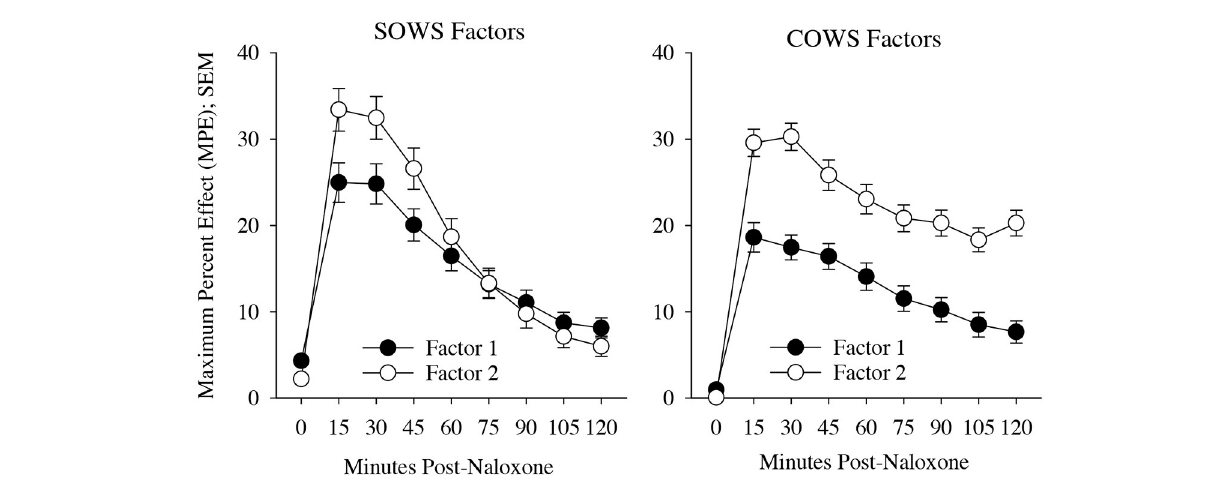
FIGURE3 Precipitated withdrawal symptoms. Change in factors for the Subjective Opiate Withdrawal Scale (SOWS, left) and Clinical Opiate Withdrawal Scale (COWS, right) over time ( X -axis; standard error of the mean [SEM]). Factors were derived using principal component analyses based on symptom severity ratings collected at the time of peak withdrawal following 0.4mg (intramuscular) naloxone dosing. Scales are converted to maximum percent effect (MPE) along Y -axis for comparison. SOWS Factor 1 included 11 symptoms (nausea, vomiting, restlessness, anxiety, shaking, muscle twitching, stomach cramps, feel like using, cold flashes, gooseflesh, and bone and muscle aches) and SOWS Factor 2 included five symptoms (eyes tearing, yawning, nose running, perspiring, and hot flashes). COWS Factor 1 included seven symptoms (gastrointestinal upset, tremor, restlessness, anxiety or irritability, bone or joint aches, gooseflesh, and yawning), and COWS Factor 2 included two symptoms (pupil size and rhinorrhea/lacrimation). Two COWS symptoms (resting pulse rate and sweating) did not load on any factor.